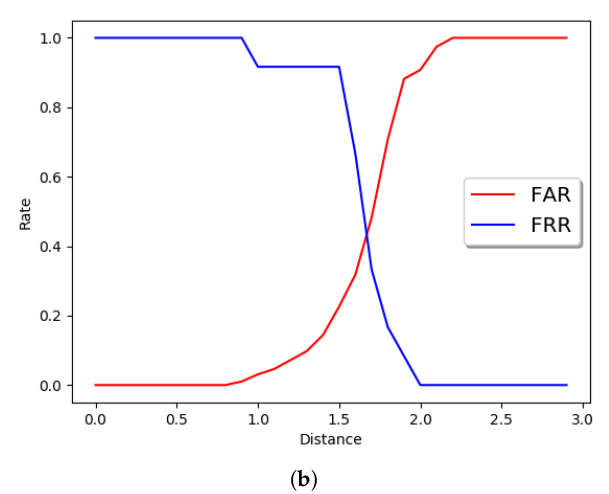
Figure 9. ( a ) Confusion matrix obtained for different floors’ matching. ( b ) FAR and FRR obtained.